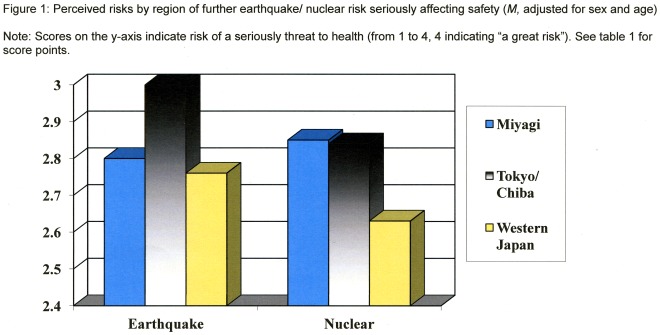
Perceived risks by region of further earthquake/nuclear risk.Note: Scores on the y-axis indicate risk of a seriously threat to safety (from 1 to 4, 4 indicating “a great risk”). See table 1 for score points.